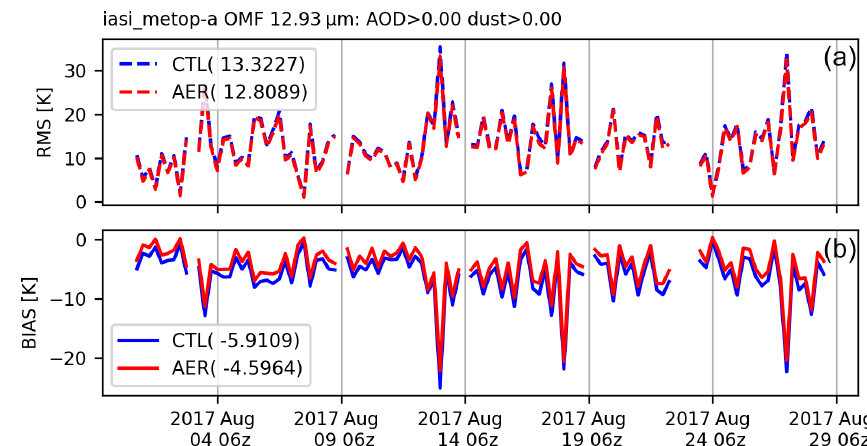
Figure 3. Statistics for the observation-minus-forecast (OMF) infrared brightness temperatures (IR BTs; 12.93µm) from the Infrared Atmo- spheric Sounding Interferometer (IASI) hyperspectral sensor from CTL (red) and AER (blue). The time series includes all observations over the region (0–40 ◦ N, 20 ◦ E–30 ◦ W), irrespective of the aerosol loading. The numbers in the legend are the mean values for the (a) RMS (root mean square) and (b) bias for each experiment.